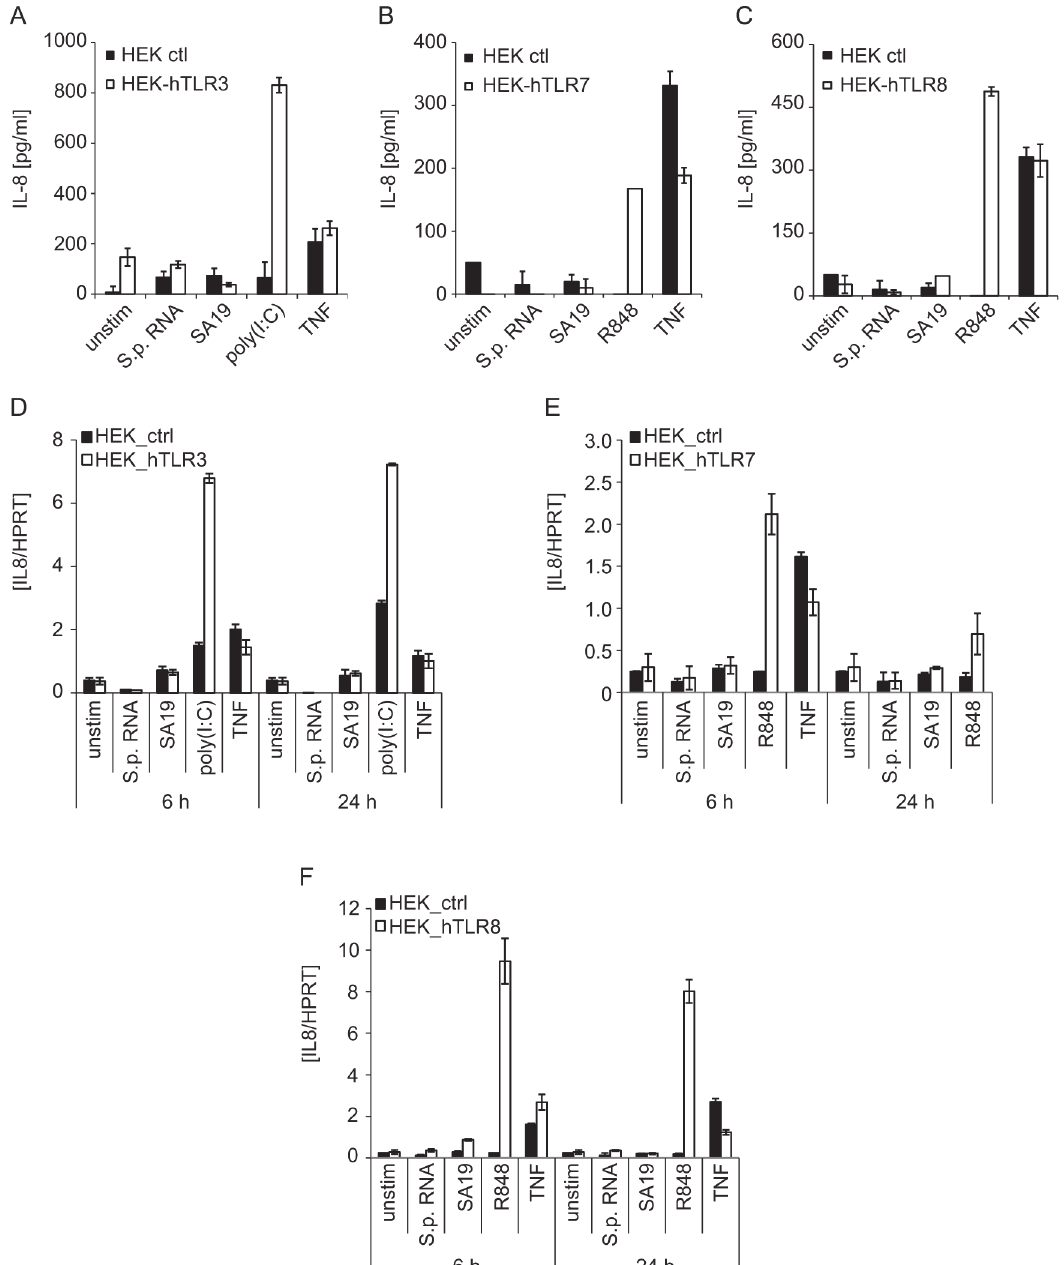
Fig 4. Human RNA-recognizing TLRs are not capable of sensing S . pyogenes RNA. (A, D) HEK293 stably expressing human TLR3 (HEK293-hTLR3) or control HEK293 cells (HEK ctl) were transfected with the TLR3 ligand poly(I:C) (5 μ g), the Tlr13 ligand oligoribonucleotide SA19 (5 μ g), S . pyogenes RNA (5 μ g) using DOTAP or stimulated with human TNF (10 ng/ml). IL-8 release was measured in supernatants 24 h post stimulation by ELISA (A) or the levels of IL8 mRNA were determined by qRT-PCR (normalized to HPRT ) (D). Mean values ± SD are shown (n (cid:3) 3). (B, C, E, F) HEK293XL cells stably expressing human TLR7 (B, E) or TLR8 (C, F) or control HEK293XL cells were transfected with SA19 (5 μ g), S . pyogenes RNA (5 μ g) or stimulated with the TLR7 and TLR8 ligand R848 (5 μ g/ml) or human TNF (10 ng/ml). IL-8 release was measured in supernatants 24 h post stimulation by ELISA (B, C) or the levels of IL8 mRNA were determined by qRT-PCR (normalized to HPRT ) (E, F). Mean values ± SD are shown (n (cid:3)